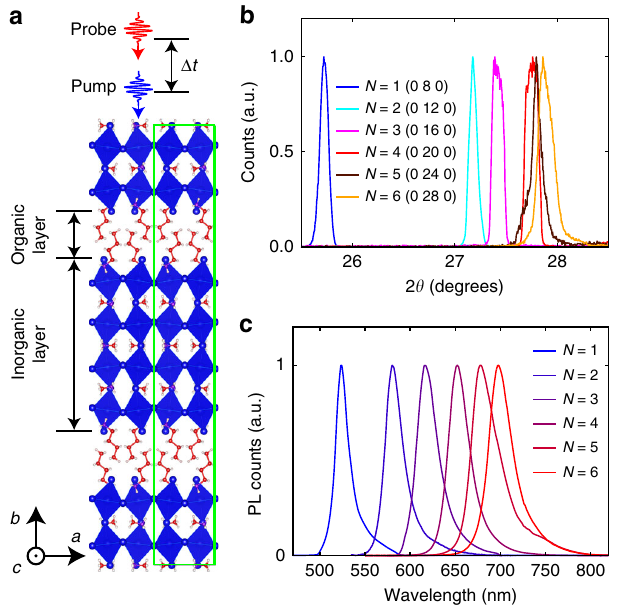
Fig. 1 The crystal structure and phase purities of 2D RPs. a The crystal structure of N = 4 with a unit cell enclosed by the green rectangle. The directions of the pump and probe beams with respect to the crystal orientation are illustrated on the top. b Characteristic X-ray diffraction peaks of the single-crystal fl akes ( N = 1 – 6) obtained from θ – 2 θ scans. c Photoluminescence spectra of the 2D